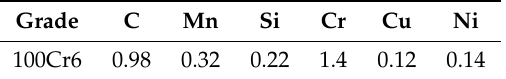
Table 1. Composition of 100Cr6 steel (wt